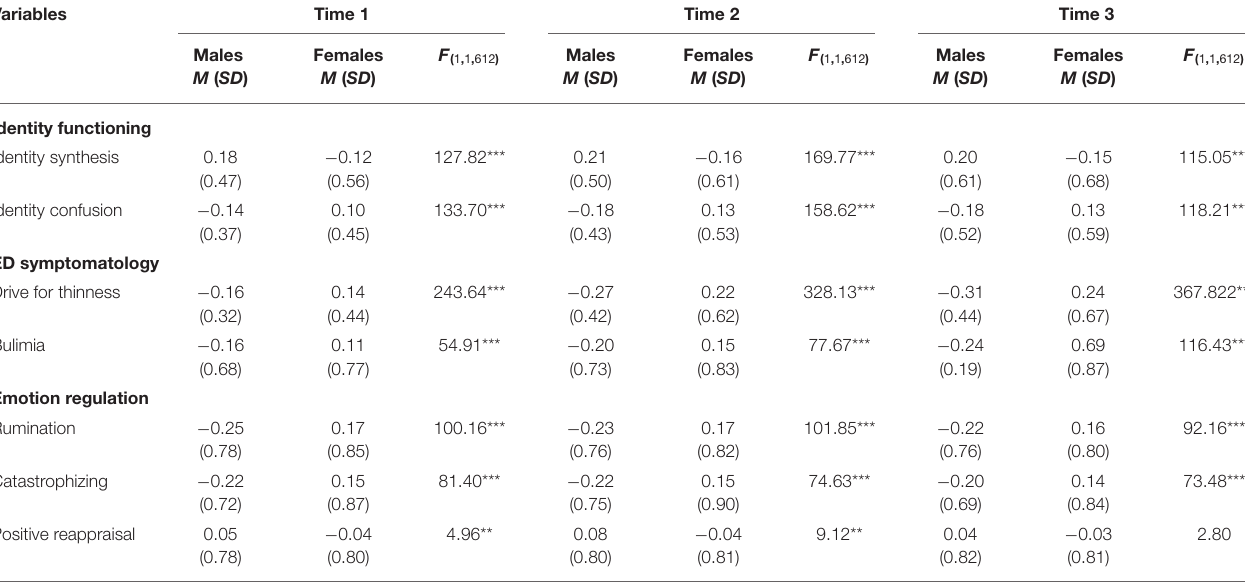
TABLE 1 | Gender Distribution of Identity Functioning, ED Symptomatology, and Emotion Regulation with Univariate ANOVA’s.